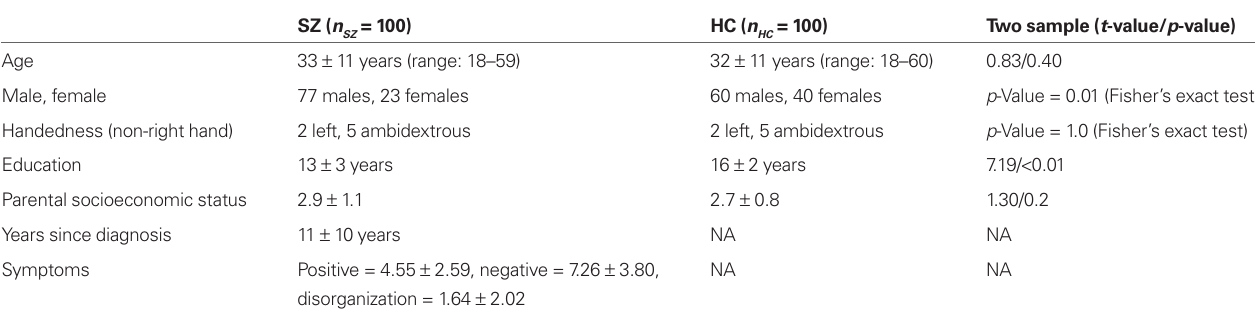
Table 1 | Demographics of SZ and HC with symptom scores for SZ.